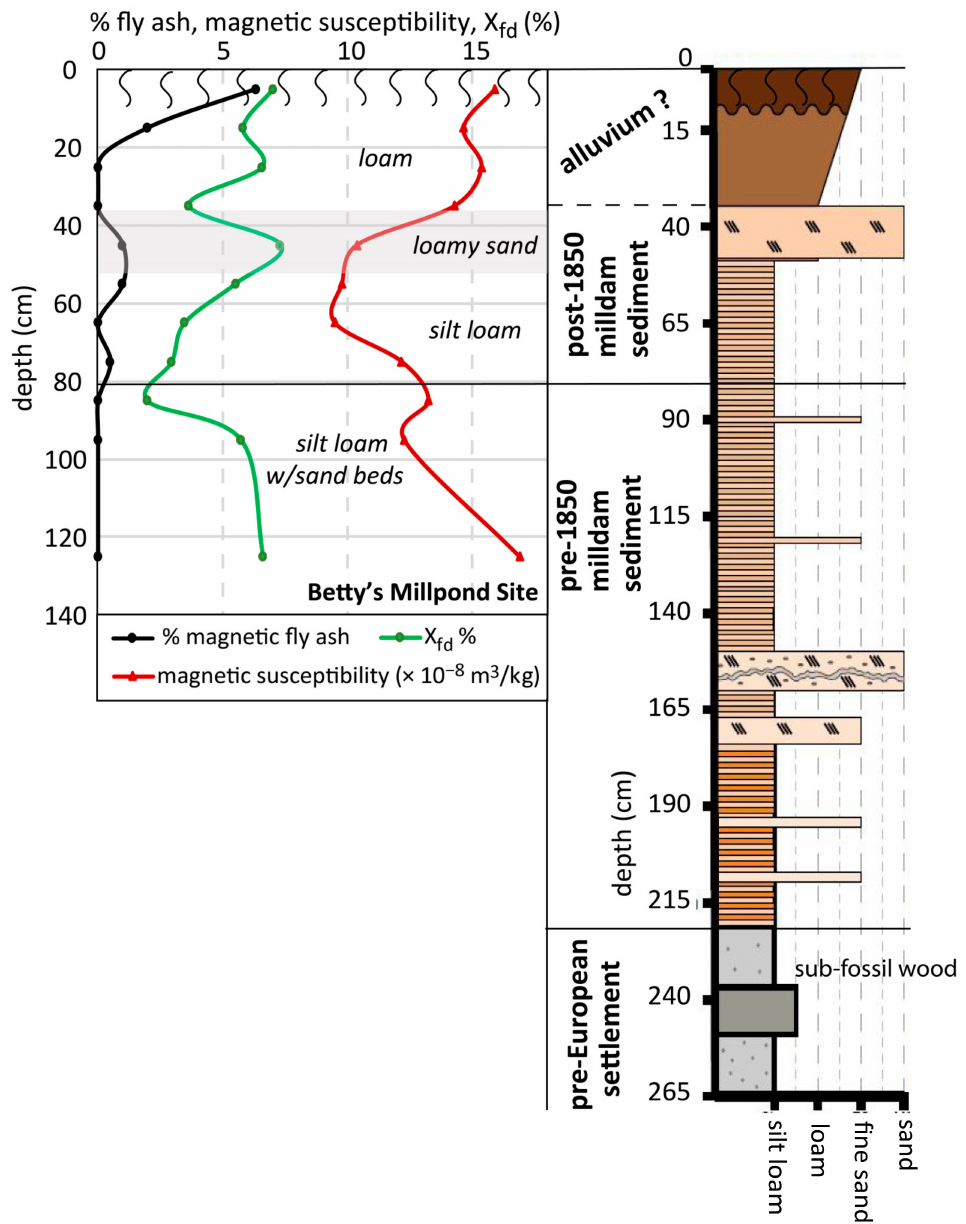
Figure 7. Fly ash, magnetic susceptibility, and frequency dependent magnetic susceptibility data from the upper 1.3 m of the Betty’s Milldam Section. Rooted tree stumps from the pre-settlement alluvium previously yielded a radiocarbon age of 1255 ± 15 14 C yr B.P. [27]. The stratigraphic sketch is modified from [37] and